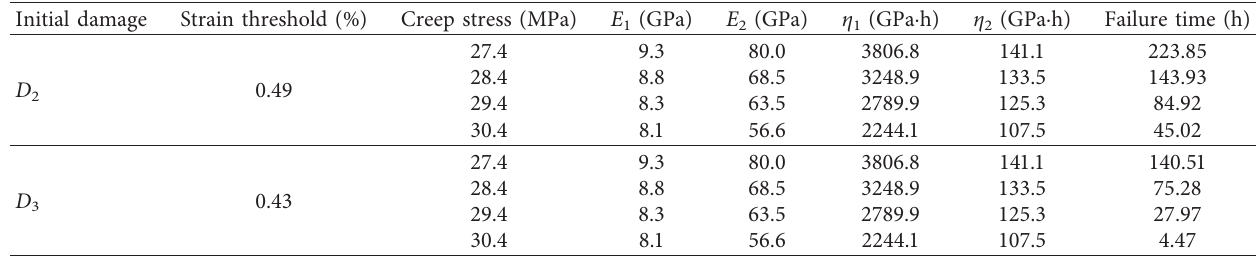
Table 8: Creep parameters and failure time of rock specimens with initial damage D Initial damage Strain threshold (%)